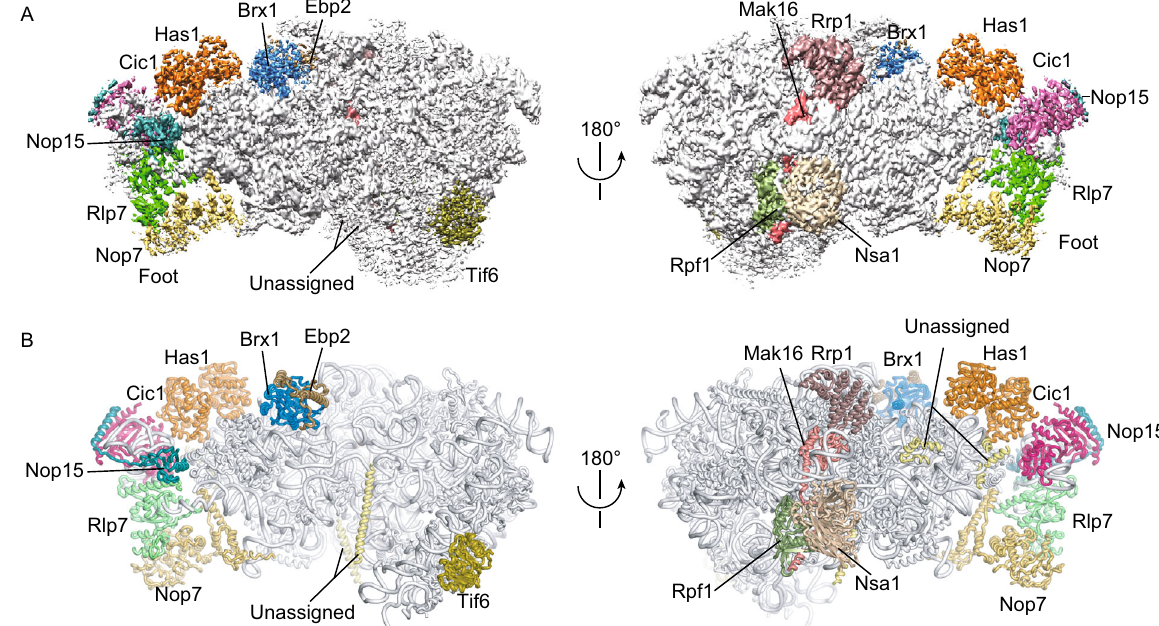
Figure 1. Cryo-EM structure of Rpf1-TAP pre-60S. (A) Cryo-EM density map in two opposite views. The densities for AFs are color coded. (B) Structural model in the same views as (A). The rRNAs and RPLs are colored grey and the AFs are color